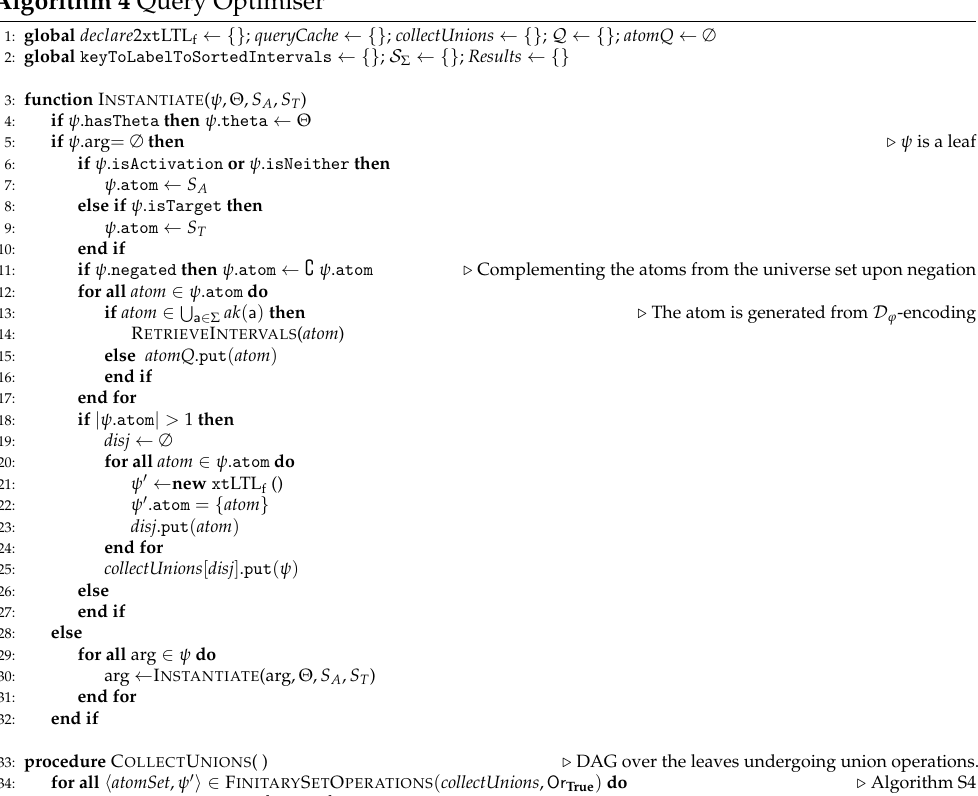
Algorithm 4 Query